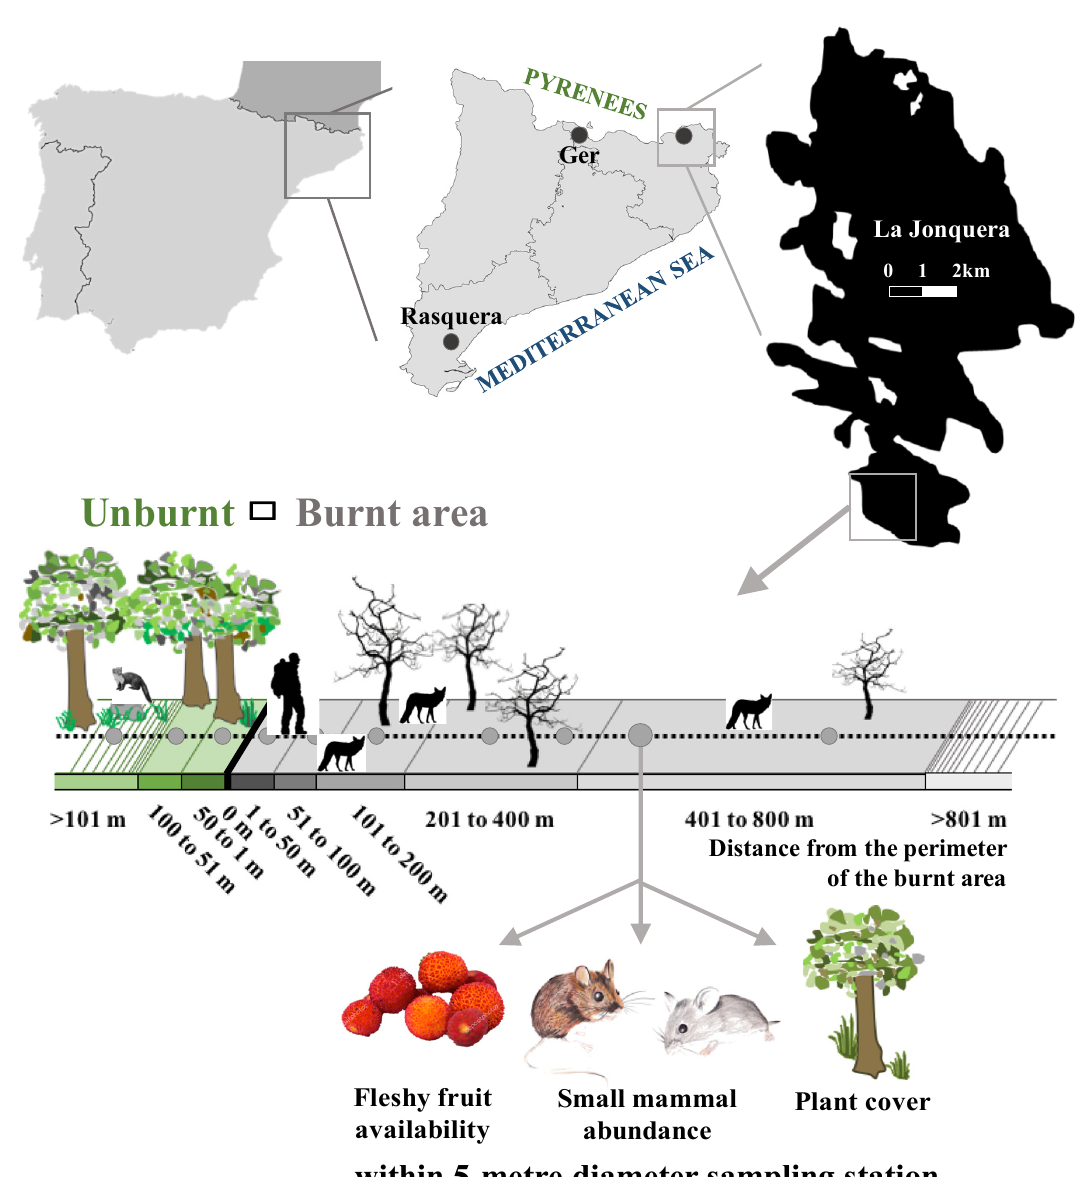
Figure 1. Location and schematic representation of the sampling methods. Location of the three study areas in Catalonia (NE Iberian Peninsula), using the La Jonquera burnt area as an example in black [40], and schematic representation of linear transects, perpendicular to the burnt area perimeter with sampling stations (grey dots) at increasing distances from the burnt area perimeter. In each sampling station of 5 m diameter, we measured vegetation structure, production of trophic resources, and relative abundance of small-mammals (with a Sherman live trap).